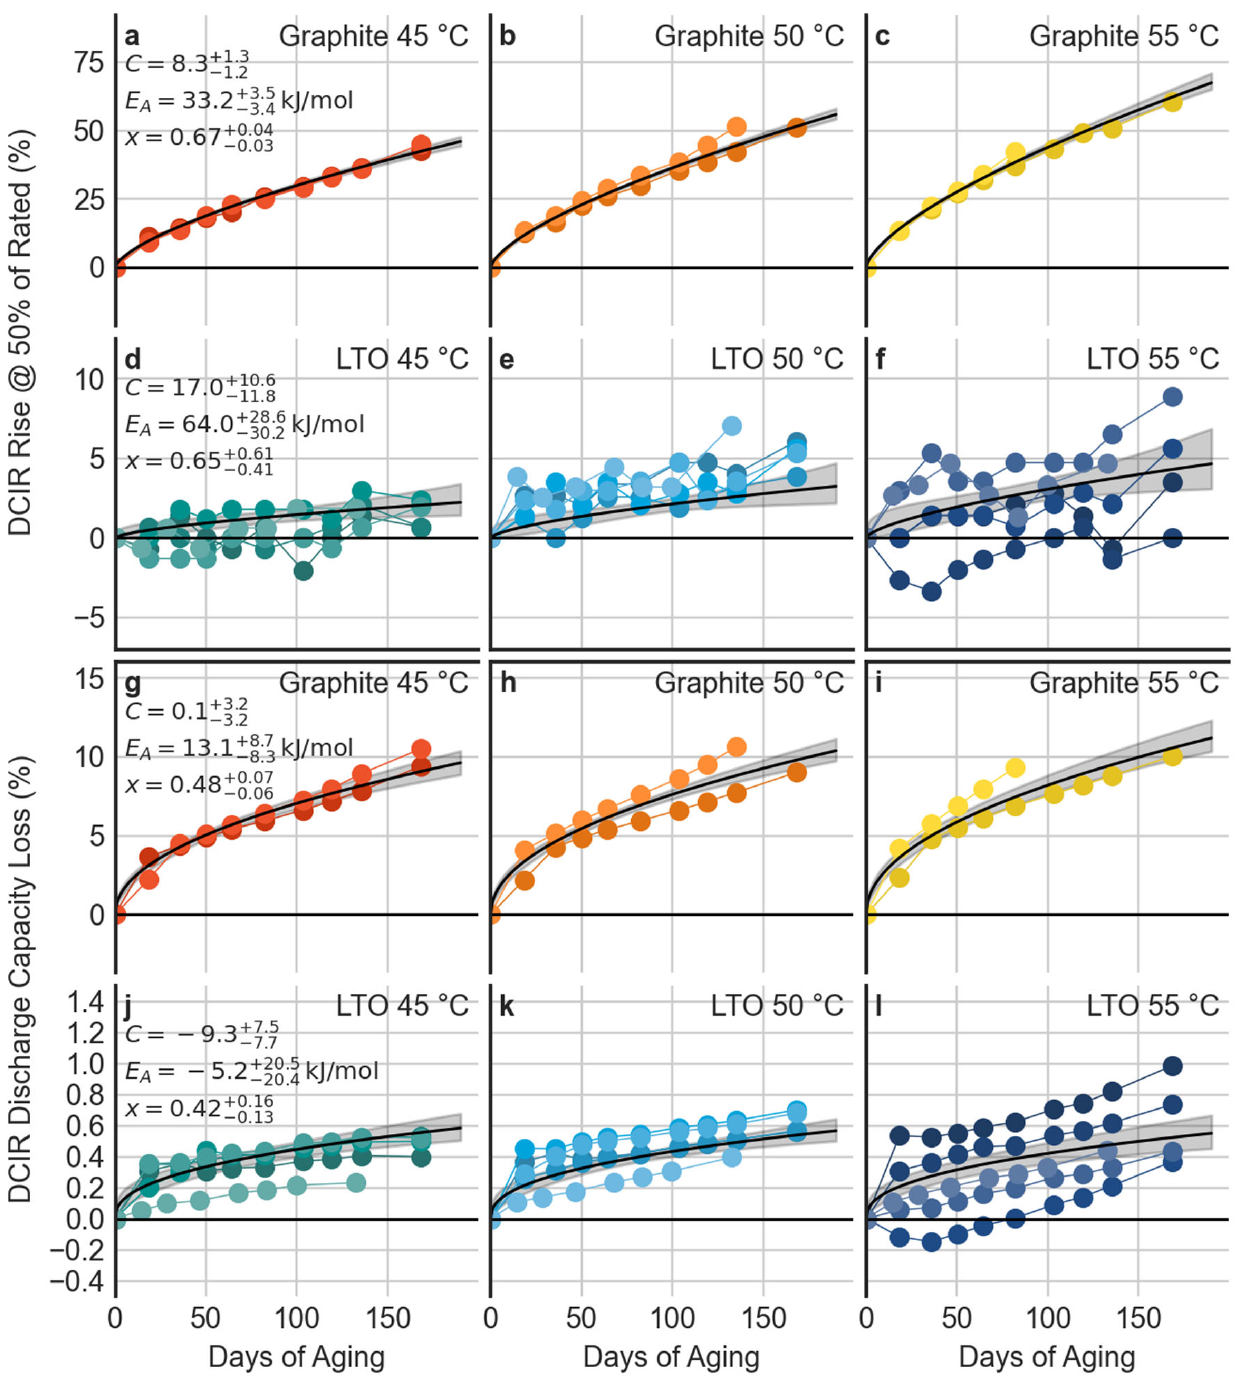
Figure 13. Aging data and modeled predictions. For all plots, colored dots and lines reflect the measured data, while the solid black curves reflect the model prediction. Shaded regions reflect the 95% confidence interval for the population average. Fit parameters are shown on the left-most plot in each row. Top two rows ( a – f ) the rise in DCIR at 50% DoD. Bottom two rows ( g – l ) the C/24 discharge capacity.